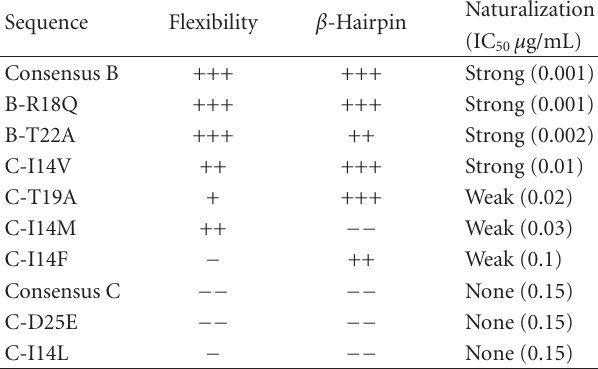
Table 1: antibody-mediated neutralization of psVs constructed from SF162 with the V3 loop replaced by the consensus C or consensus B V3 loop sequence with and without the indicated point mutations in the “Sequence” column. In vitro measured strong, weak, or no neutralization is indicated along with the IC 50 (ug/mL) in the “Neutralization” column on the right. Numbering of mutated residues is from the beginning of the V3 loop with the starting cysteine being residue number 1 so that D25E (V3 loop numbering) is the same as D322E (numbering of residues from N-terminus of gp120). The “Flex” column is the structural flexibility of the V3 crown from positions 10 to 22 as assessed by ab initio folding: +++ indicates no energy gap and many conformations near the energy minimum suggesting a flexible structure; ++, +, and − indicate a spectrum of energy gaps of < 2 U slightly more than the standard error of the energy function suggesting a partly flexible structure; −− indicates an energy gap > 2 U indicating a rigid conformation. The “ β -hairpin” column is the β -strand character of positions 12 to 14 as assessed in the same ab initio folding: +++ indicates that all three residues from 12 to 14 adopt canonical β -strand φ and Ψ angles in the lowest energy structure; ++ indicates that two of the three residues from 12 to 14 adopt canonical β -strand φ and Ψ angles; + indicates that two or more of the residues from 12 to 14 adopt canonical β -strand φ and Ψ angles, but that the overall structure does not form a β -hairpin. – and −− indicate that residues from 12 to 14 adopt canonical non- β -strand φ and Ψ